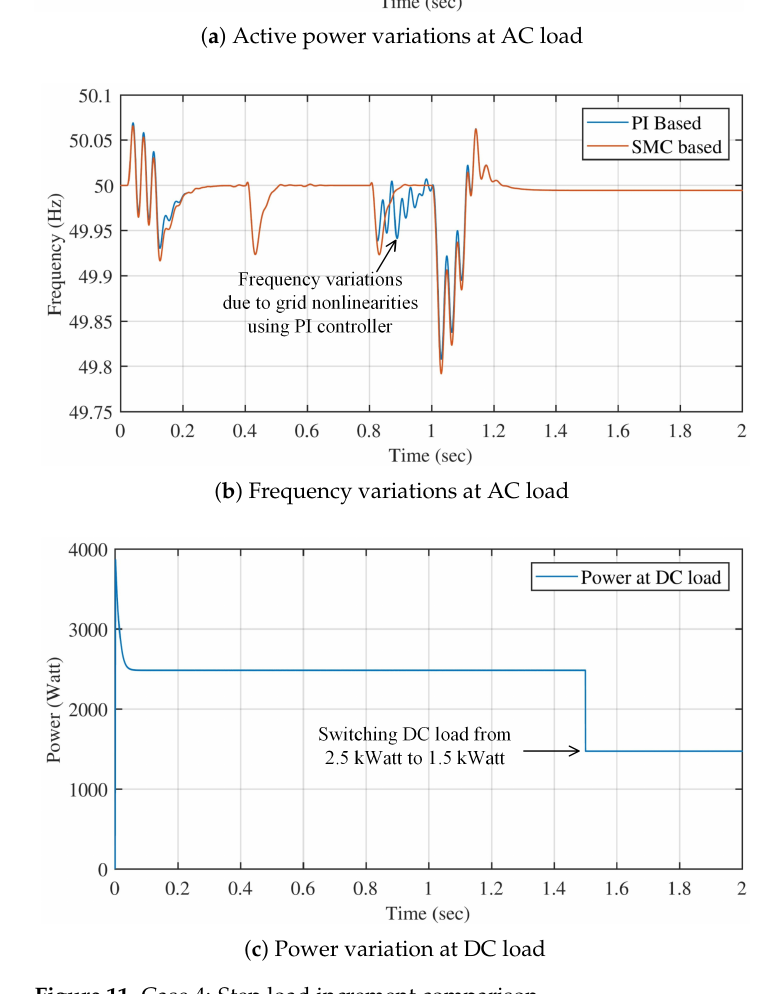
Figure 11. Case 4: Step load increment